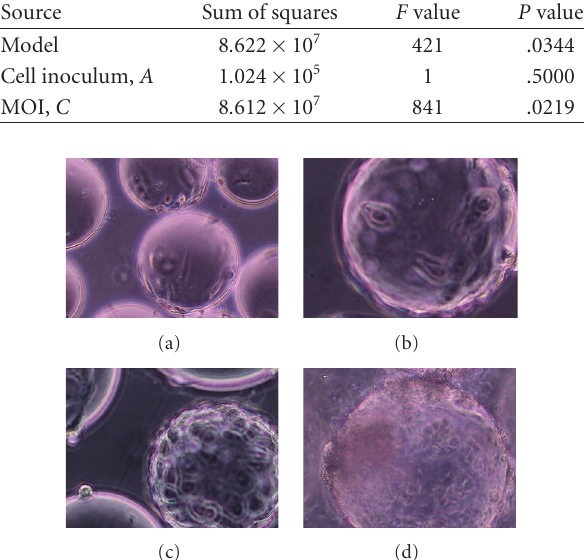
Figure 5: Monitoring of Cytodex 1 microcarriers during cell growth and NDV production phases of Vero cells grown in a 2L bioreactor.